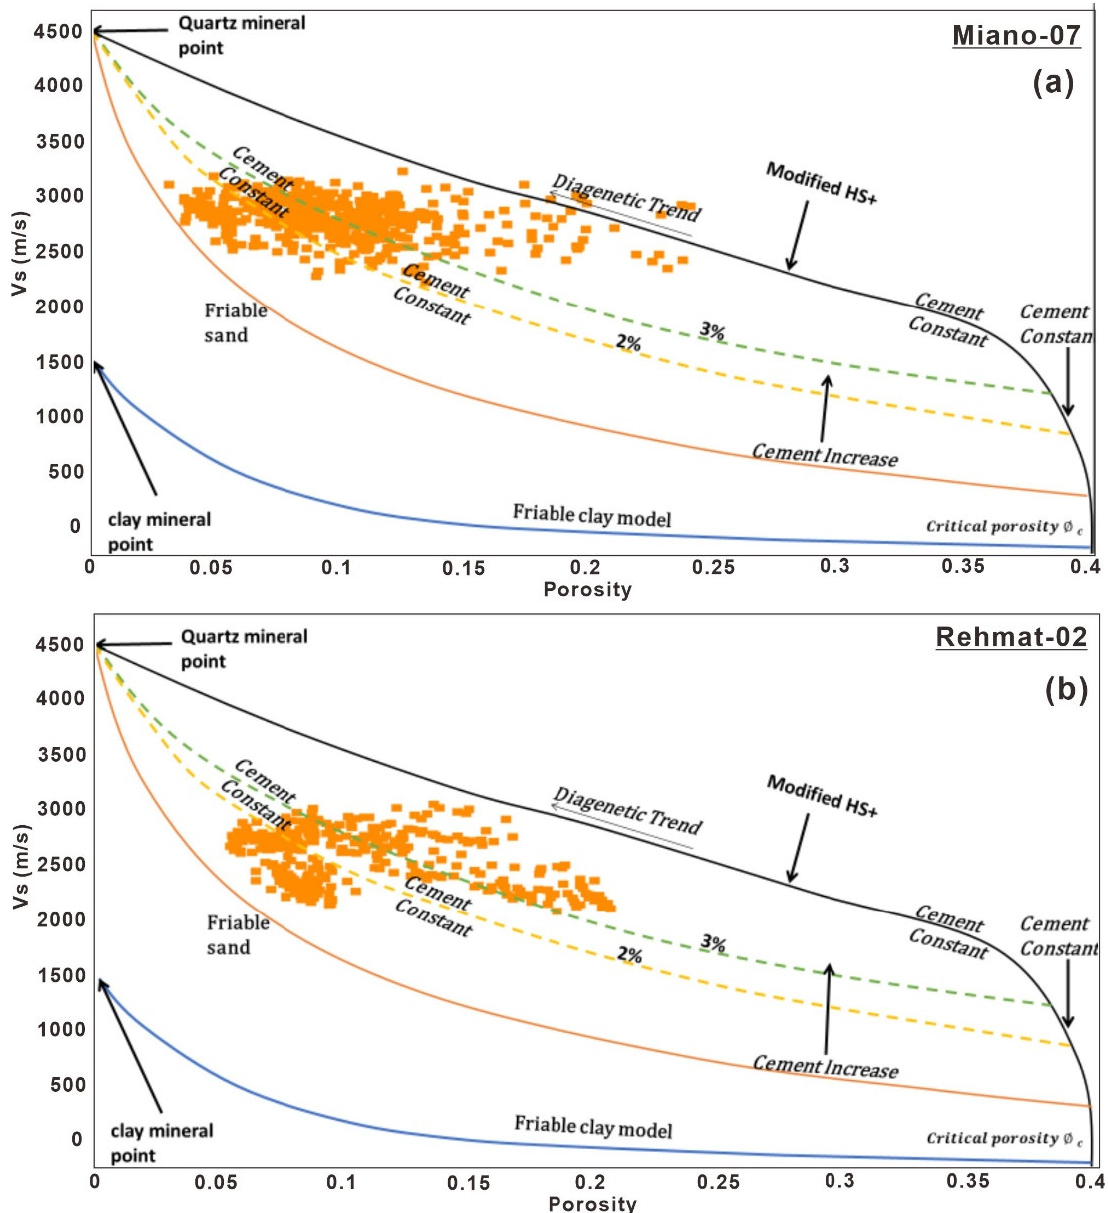
Figure 10. RPD cross-plots from ( a ) Miano-07 and ( b ) Rehmat-02, of V s versus porosity of reservoir sands utilizing the CC, CC , and FS (uncemented sand)